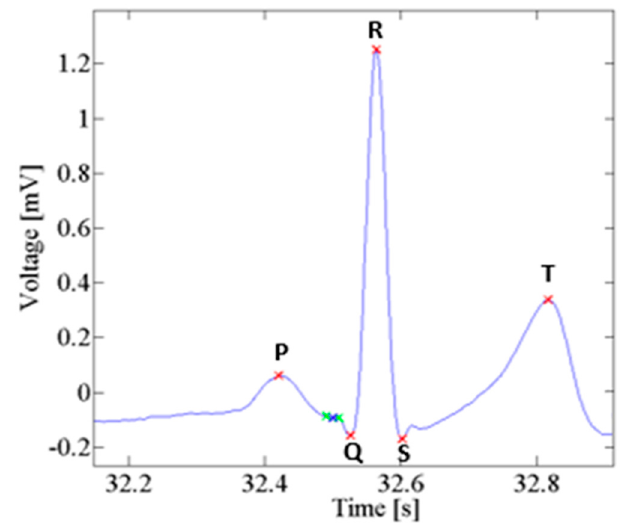
Figure 11. A compliant EEG standard waveform.